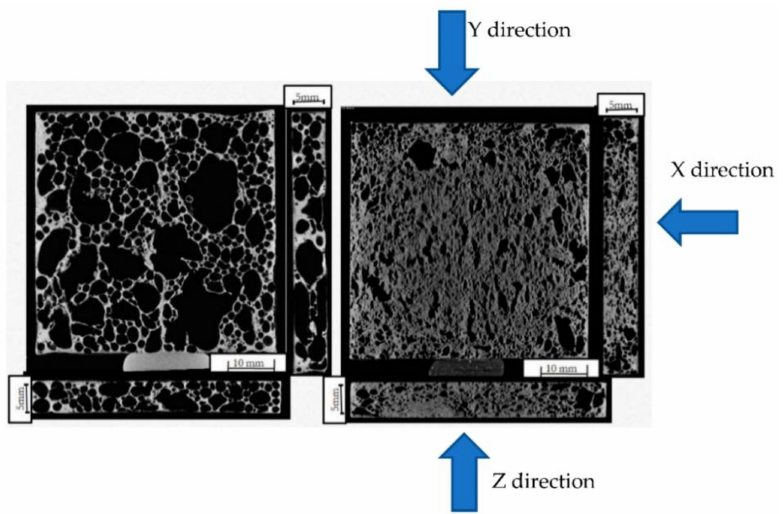
Figure 2. Typical CT slice image of the A1 and A2 aluminium foam sample at the midsection (X direction—right side view, Y direction—front view & Z direction—bottom